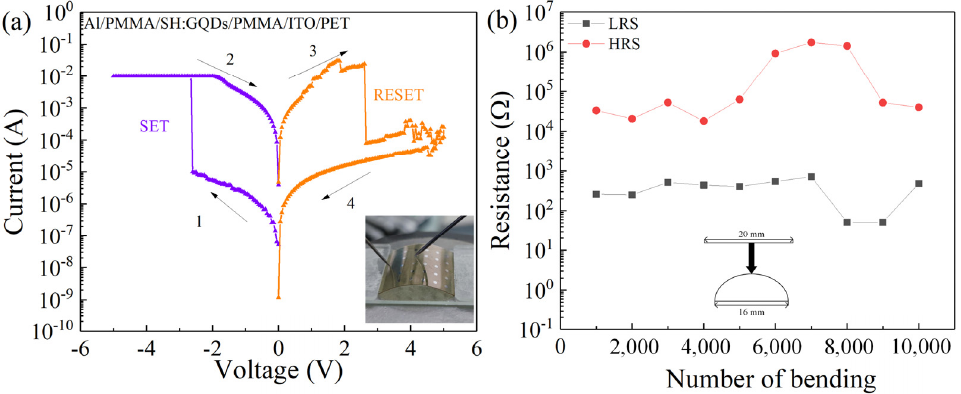
Figure 11. ( a ) I-V characteristic curve of the Al/PMMA/SH:GQD/PMMA/ITO/PET device in the bending state. ( b ) R LRS and R HRS after 10 4 bending cycles.